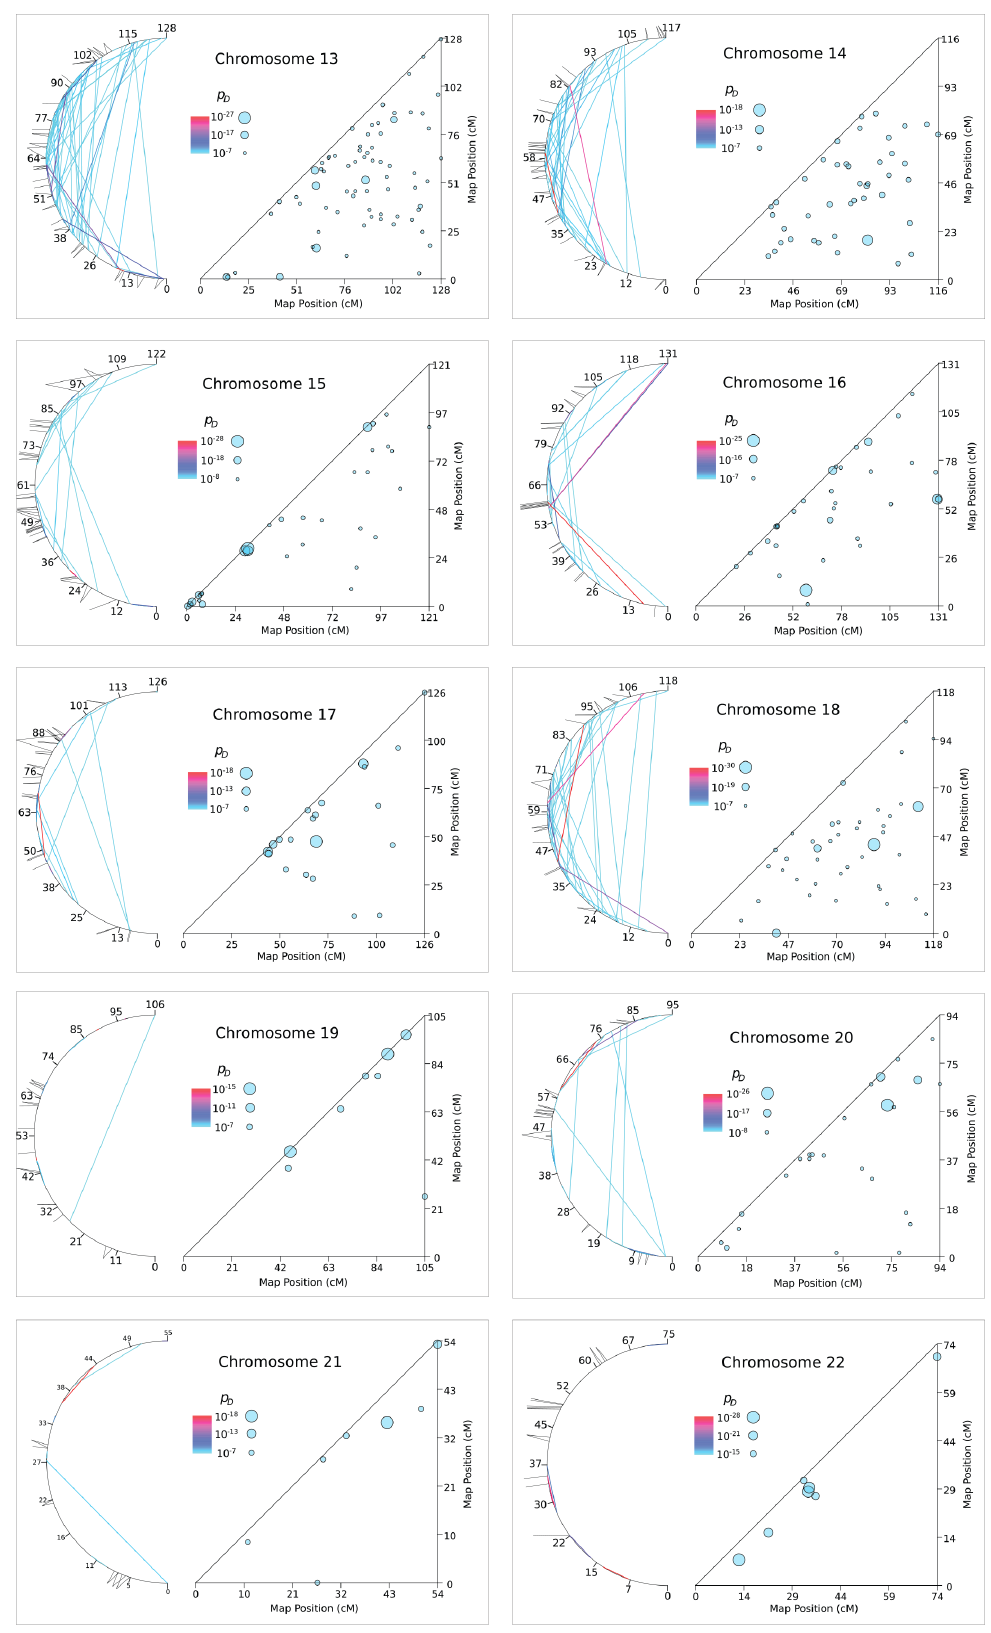
Figure 6. Patches of LRLD on Chromosome 12 to 22. doi:10.1371/journal.pone.0080754.g006 PLOS ONE |